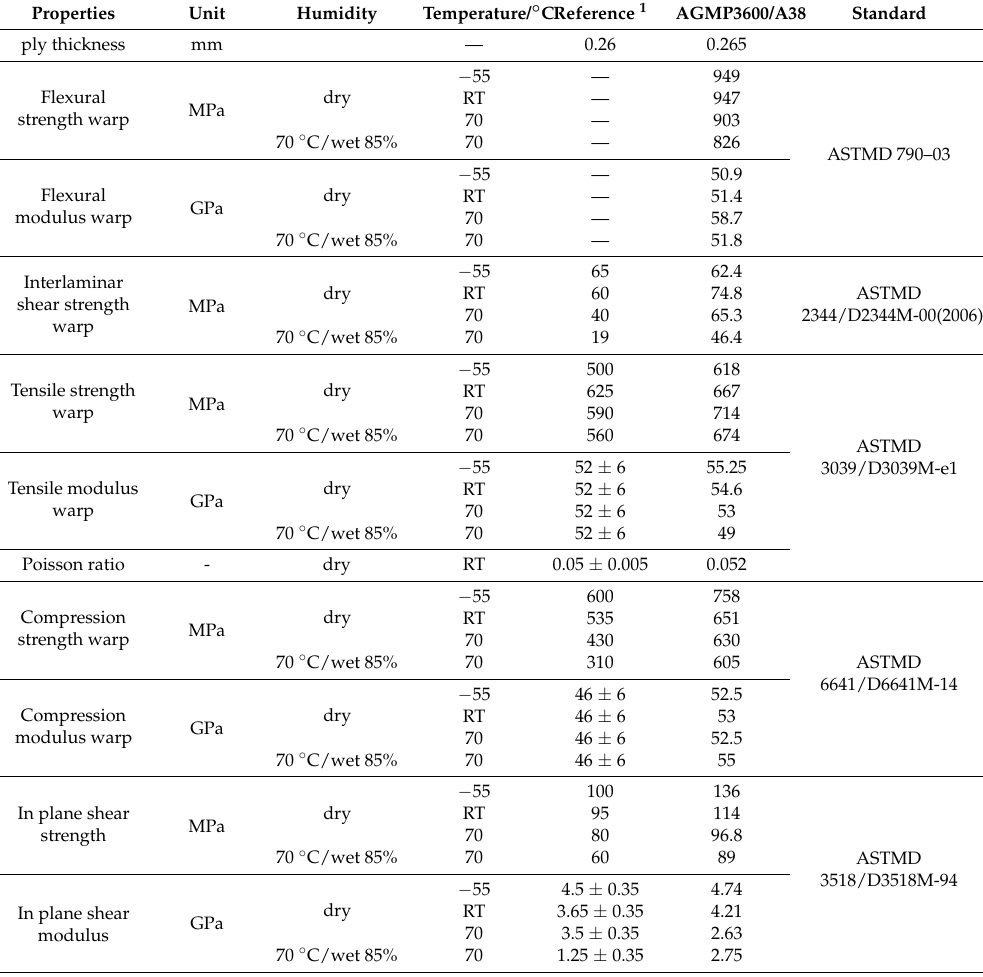
Table 3. Mechanical properties of AGMP3600/A38 (carbon fiber, twill fabric, 200 g/m 2 , 42 vol %), a rosin-epoxy laminate, under a hydrothermal condition of 1000 h/70 ◦ C/85%